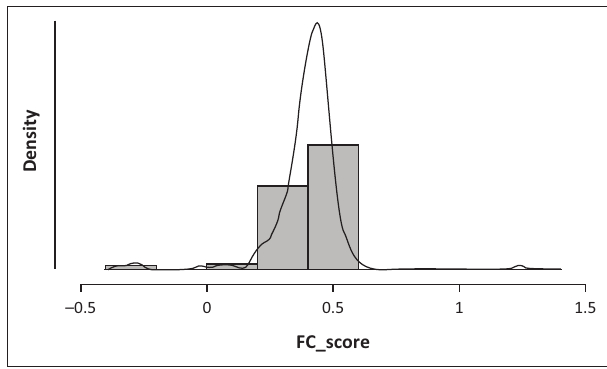
FIGURE 6: Normal distribution of financial condition scores.